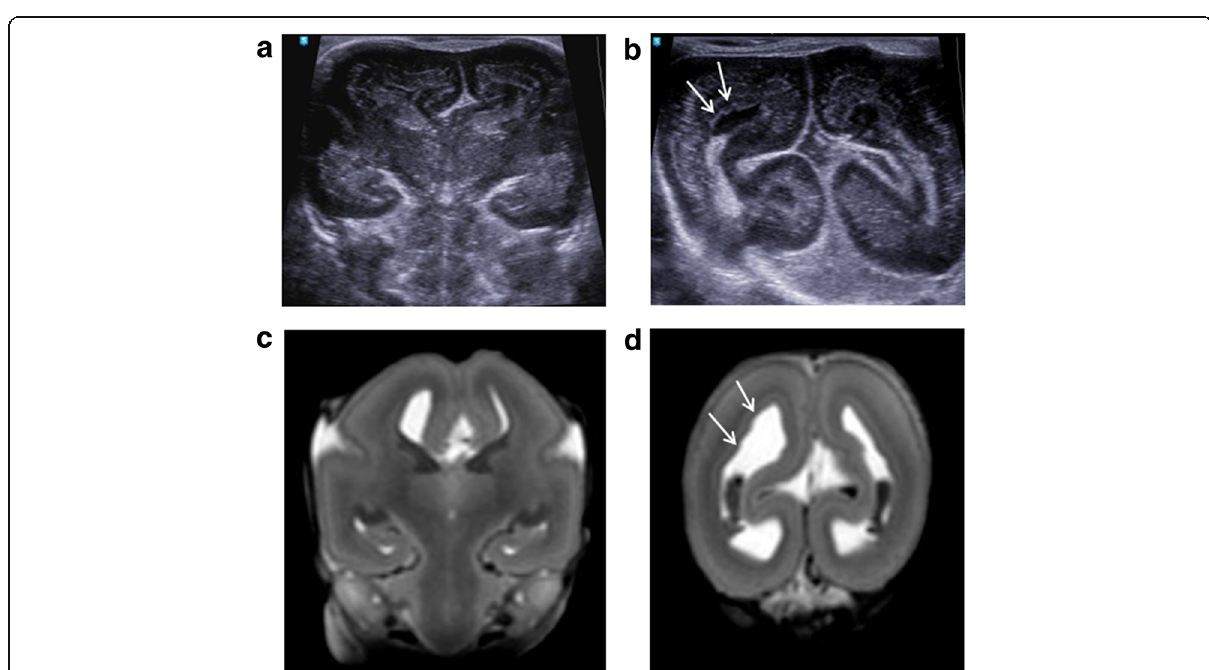
Fig. 5 Post-mortem ultrasound images of the brain, in coronal section (top row), with matched T2-weighted post-mortem MRI images (bottom row) in a foetus at 18 weeks gestation. Termination of pregnancy was performed for suspected brain anomalies. Both imaging modalities were performed on the same day, 7 days after death. The images demonstrate views through the Foramen of Monroe ( a , c ) and through the posterior horns of the lateral ventricles ( b , d ). From both imaging modalities, there is moderate ventriculomegaly, with subtle irregularity of the ependymal lining best seen along the posterior horns of the lateral ventricles. This suggests an underlying neuronal migration defect, subsequently confirmed at